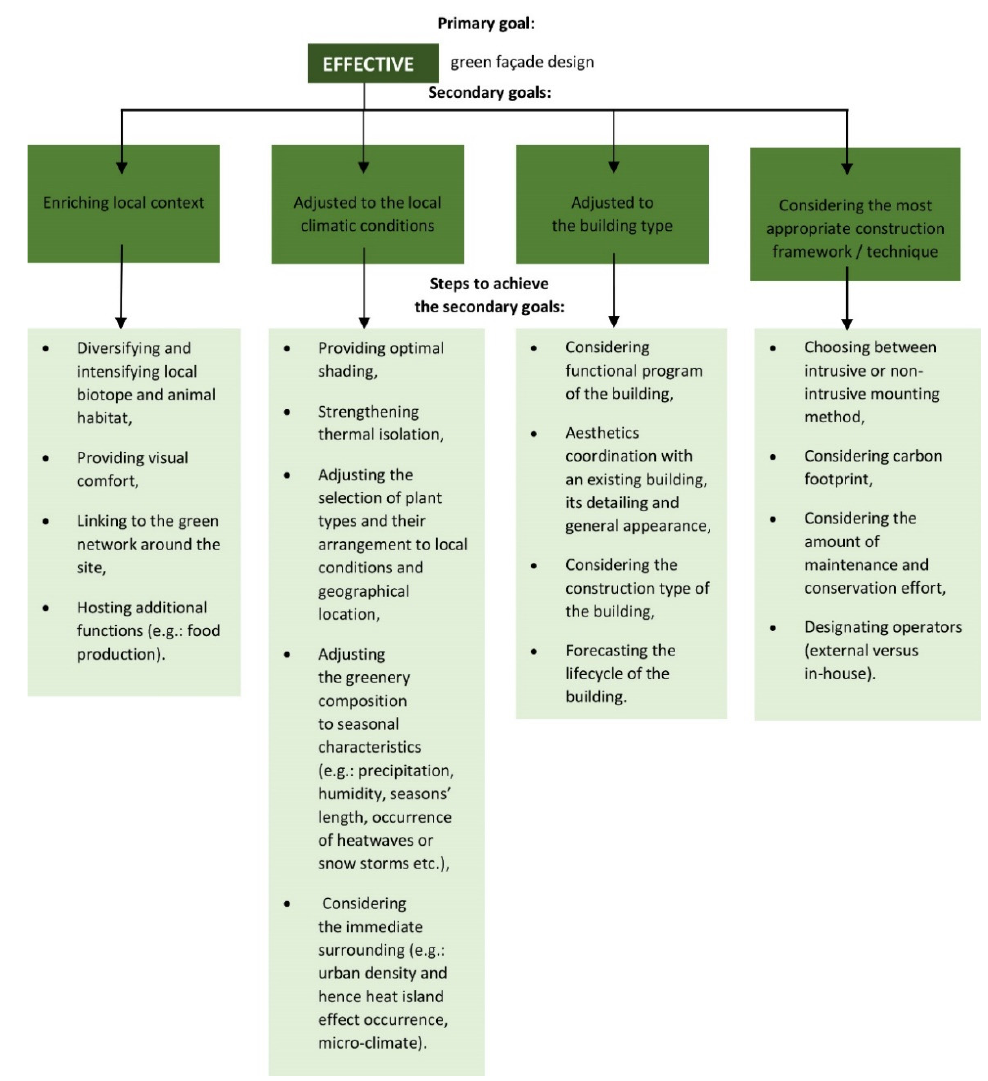
Figure 4. The backcasting scheme for defining the functionalities of the application.